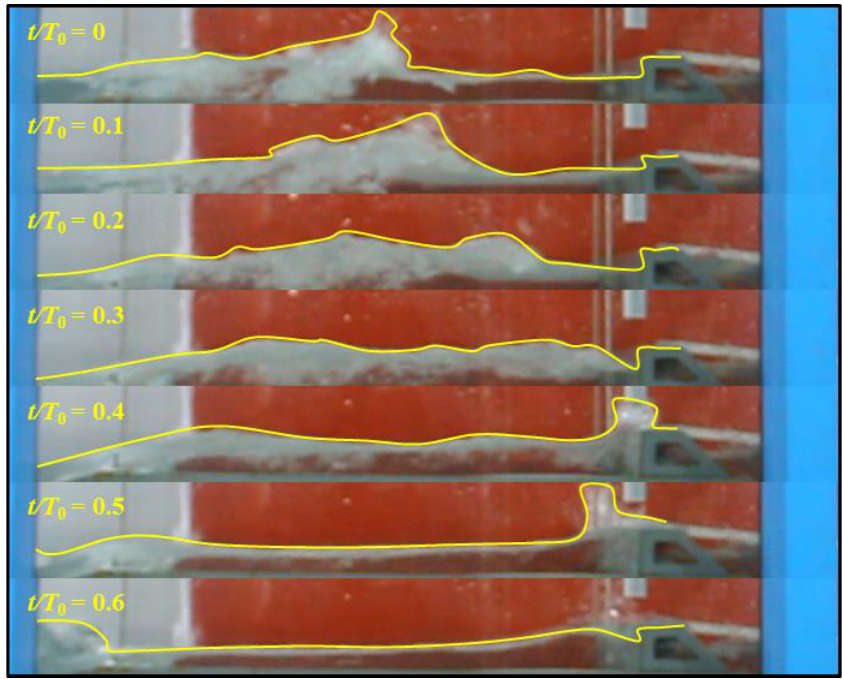
Figure 6. Wave propagation process of the vertical seawall on the reef flat for H 0 = 0.1 m, T 0 = 1.4 s, cot θ = 3, l = 1 m, and h r = 0.05 m.